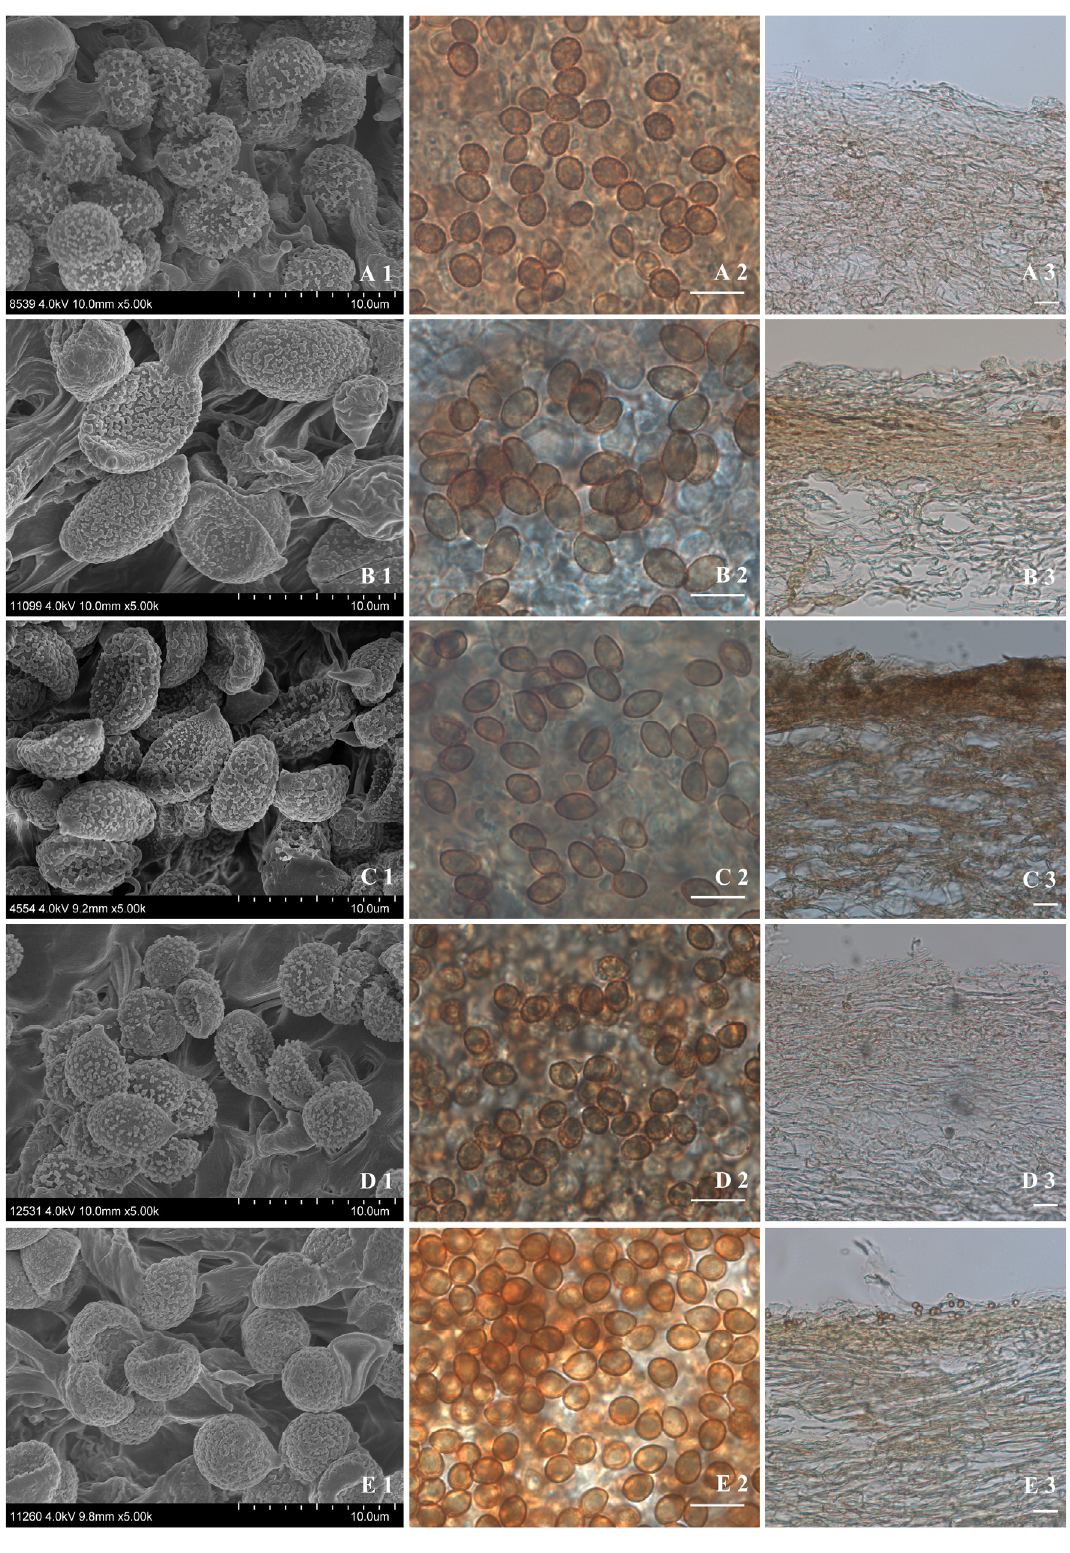
Figure 3. The basidiospores and pileipellis of the new species. ( A1 – A3 ) C. neobalaustinus , HMJAU58951, holotype; ( B1 – B3 ) C. pseudocamphoratus , HMJAU48698, holotype; ( C1 – C3 ) C. subnymphatus , HMJAU48633, holotype; ( D1 – D3 ) C. wuliangshanensis , HMJAU58940, holotype; ( E1 – E3 ) C. yanjien- sis , HMJAU58947, holotype. ( A1 – E1 ) Basidiospores under FESEM; ( A2 – E2 ) Basidiospores under microscope, bars = 10 µ m; ( A3 – E3 ) Pileipellis under microscope, bars = 20 µ